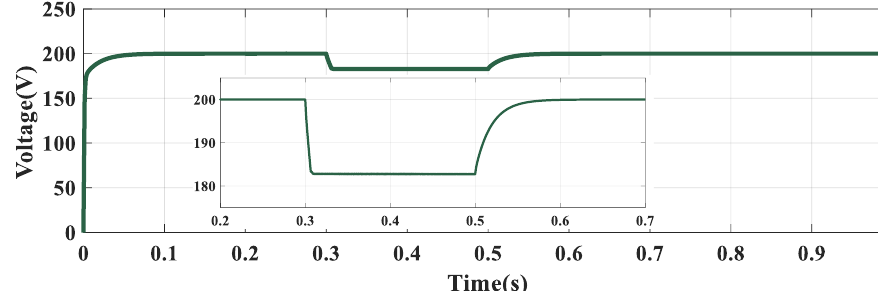
Figure 30. Study 4: load voltage (fixed weighting coefficients).